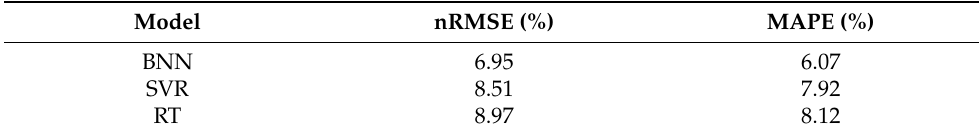
Table 3. Day-ahead photovoltaic (PV) production forecasting accuracy comparison of different machine learning predictive models trained using measured historical data, over the test set evalua- tion period.